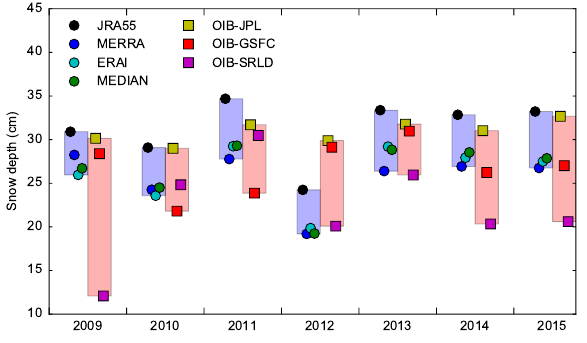
Figure 14. Comparisons of the annual mean snow depths from NE- SOSIM (default configuration) forced with different reanalyses and the various Operation IceBridge (OIB) snow depth products. The blue (red) shading represents the annual mean spread across the dif- ferent NESOSIM results (OIB products). The markers are spread across the shaded areas to improve